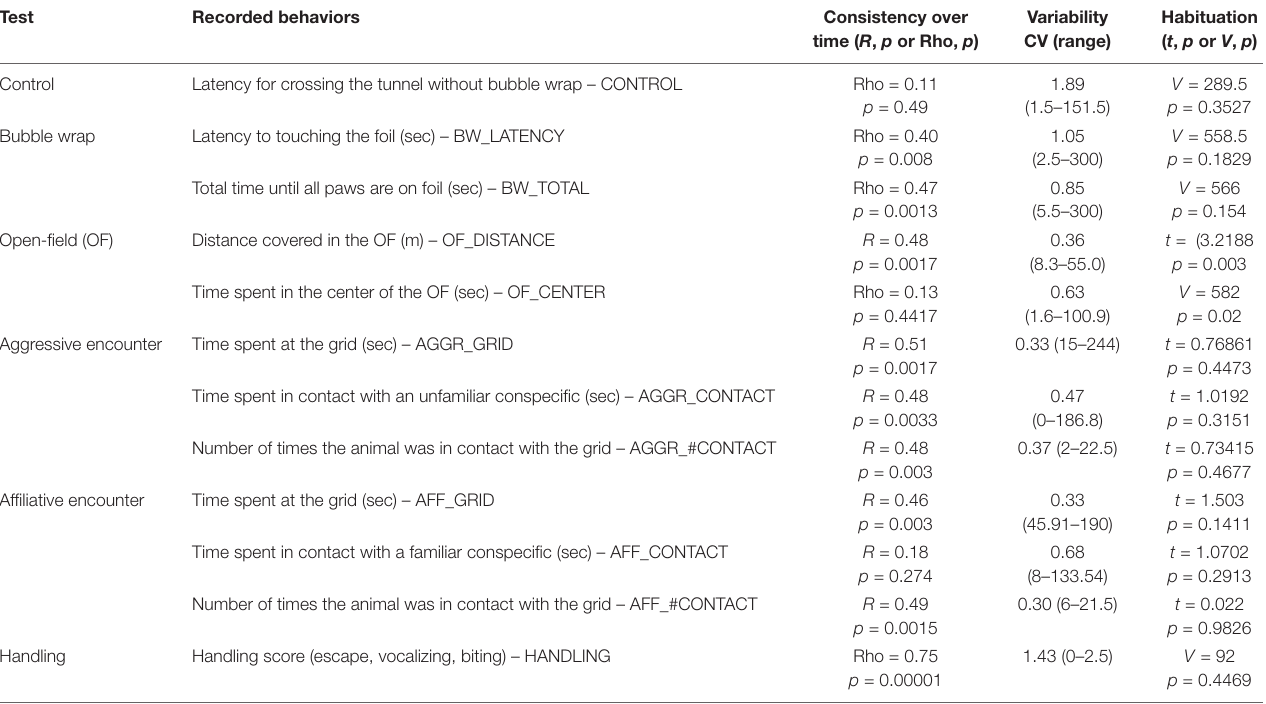
TABLE 1 | Recorded behaviors for n = 51 individuals in five tests (plus control), consistency over time (correlation between trial 1 versus trial 2, Spearman: rho, Pearson: R), variability (coefficient of variation CV measured over mean values), and habituation tests (paired t -test: t or Wilcoxon test: V ). Test Recorded behaviors Consistency over